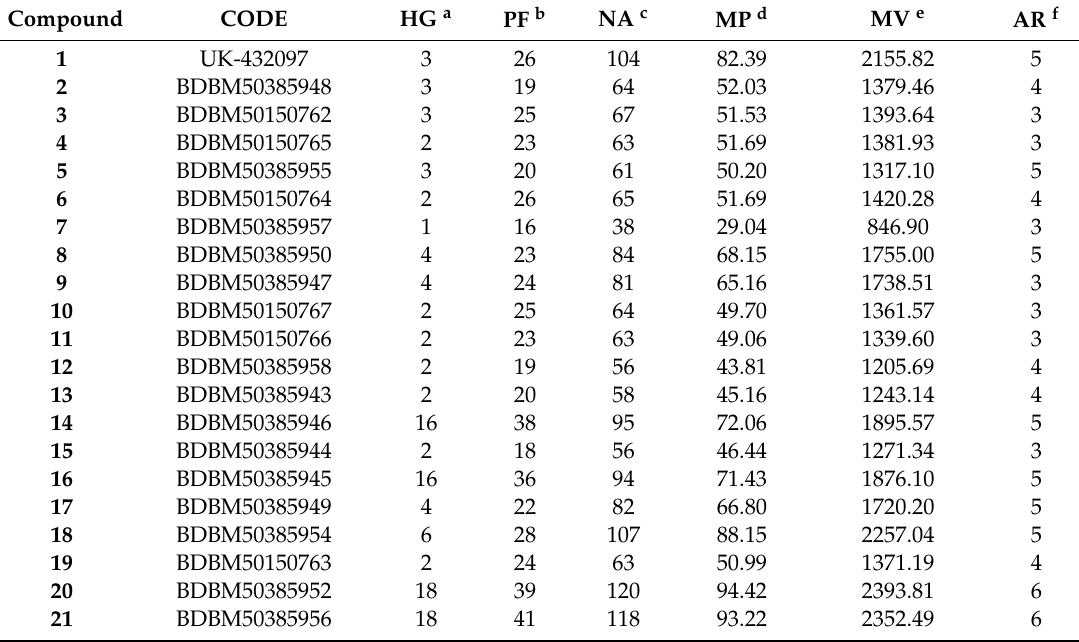
Table 2. Molecular descriptors selected for QSAR